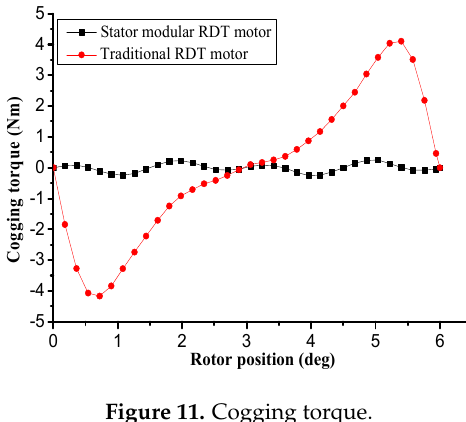
Figure 11. Cogging torque.